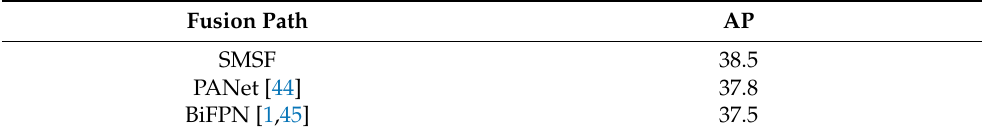
Table 1. Comparison of Fusion